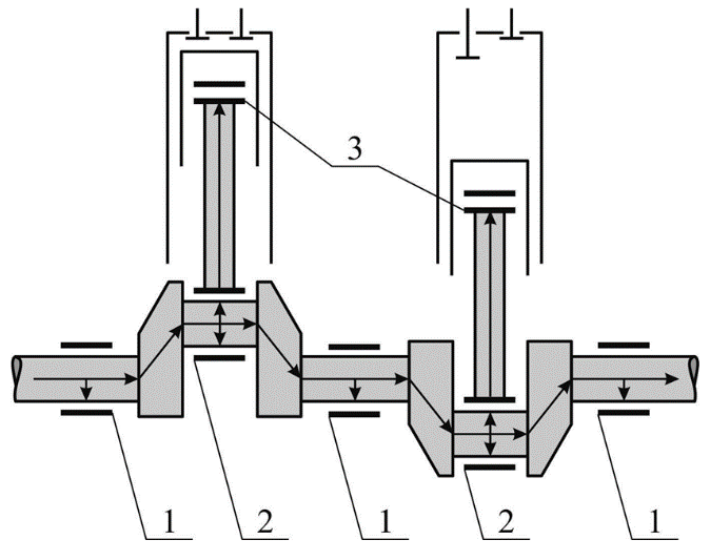
Figure 1. The movement of oil in the circulation system (fragment): 1—frame bearing; 2—crank bearing; 3—head bearing.